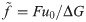
Rate of rupture of LLC (in real units of [s−1]) plotted against the non-dimensionless scaled force f˜=Fu0/ΔG, at various different values of dimensionless elasticity κ˜.The plot highlights the dramatic increase of the rate on stiffer substrates, and also the highly non-monotonic variation with force. The inset shows that on very soft substrates the rate of rupture is very low and in fact decreases further with the force. Note that the rate always diverges at f˜c=3/2, which is the maximum force that the latent complex can stand.